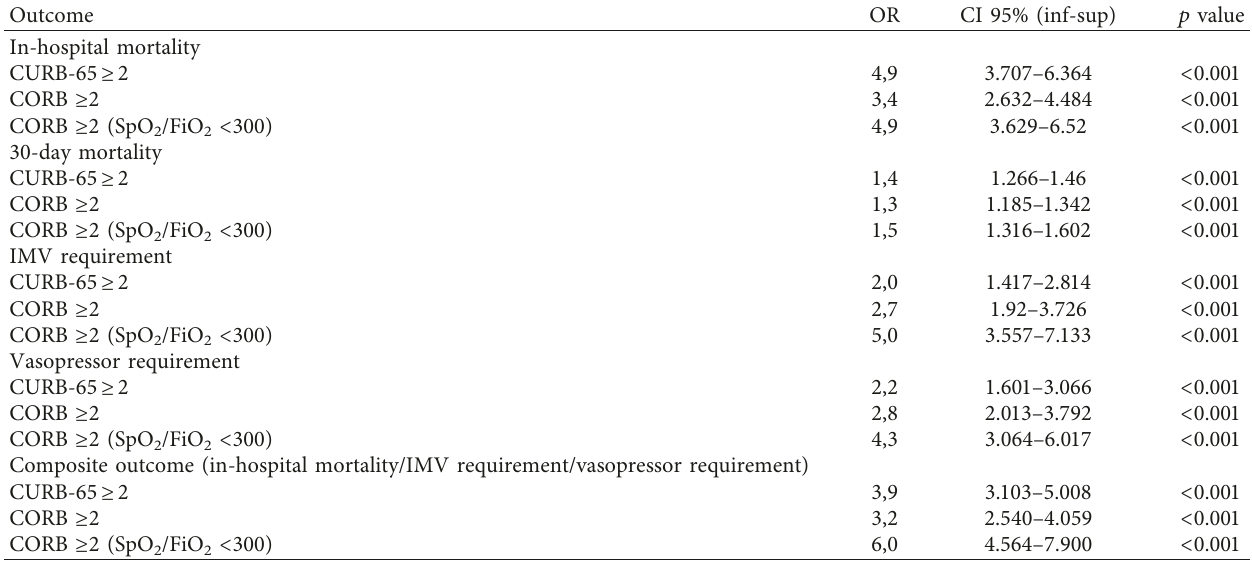
Table 2: Association of the CORB, CURB-65, and SpO 2 /FiO 2 variables with each outcome. Outcome OR CI 95%